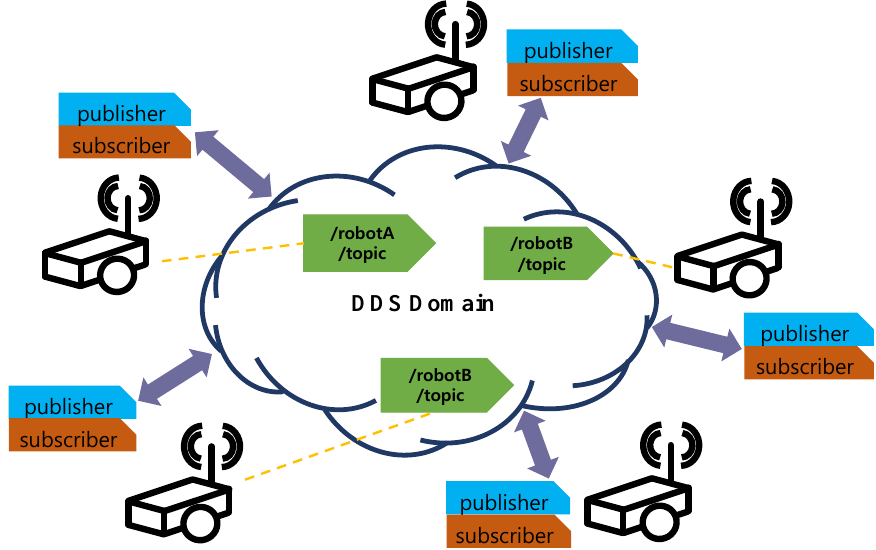
Figure 1. Data sharing in the global data space in the DDS